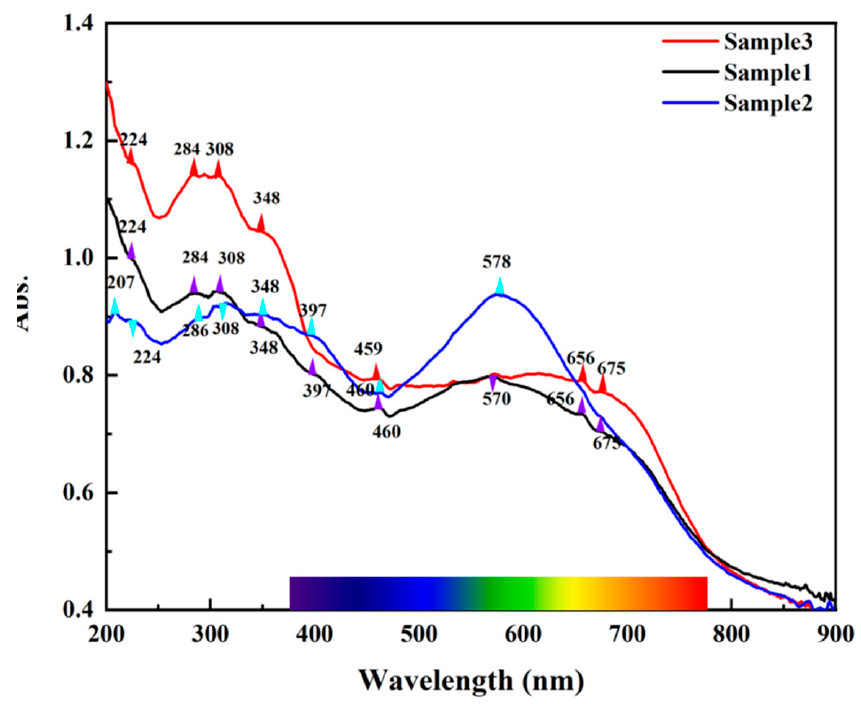
Figure 6. UV-Vis spectra of the three fluorite samples.